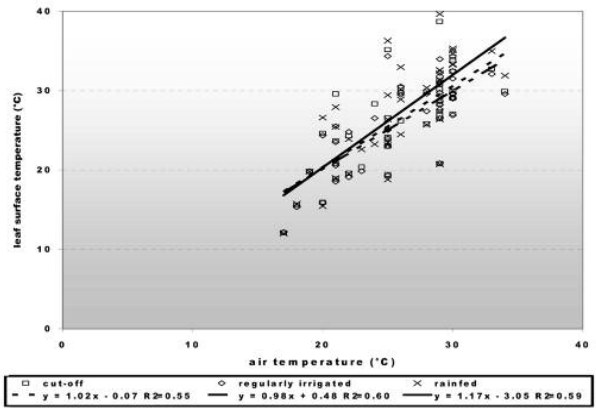
Figure 3. Correlation between canopy temperatures of different irrigated tomato treatments and air temperature, during the monitoring period at 1PM. (Brigade F , 1